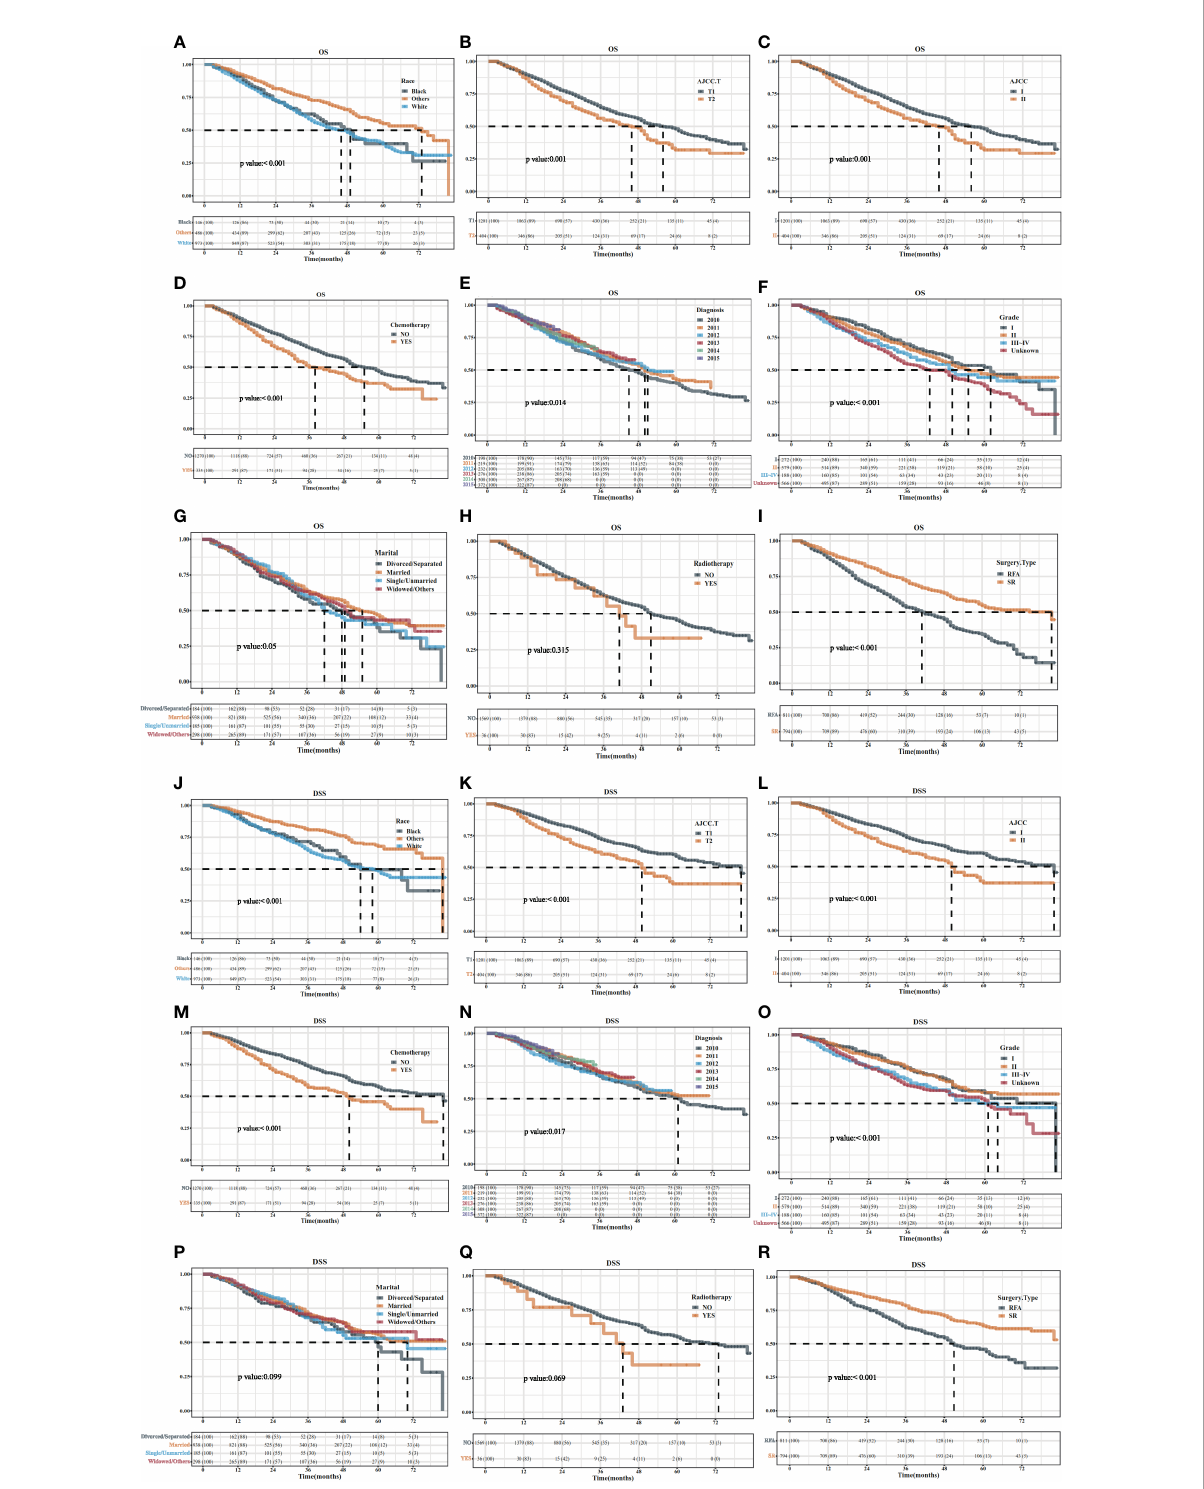
FIGURE 2 The OS and DSS curves in HCC patients with SR or SFA before PSM. The OS/DSS curves in HCC patients of different race (A/J) , AJCC T1/2 (B/ K) , AJCC 1/2 (C/L) , chemotherapy (D/M) , diagnosis (E/N) , grade (F/O) , marital (G/P) , radiotherapy (H/Q) group with SR or SFA before PSM. (I/R) The OS/DSS curves in HCC patients with SR or SFA before